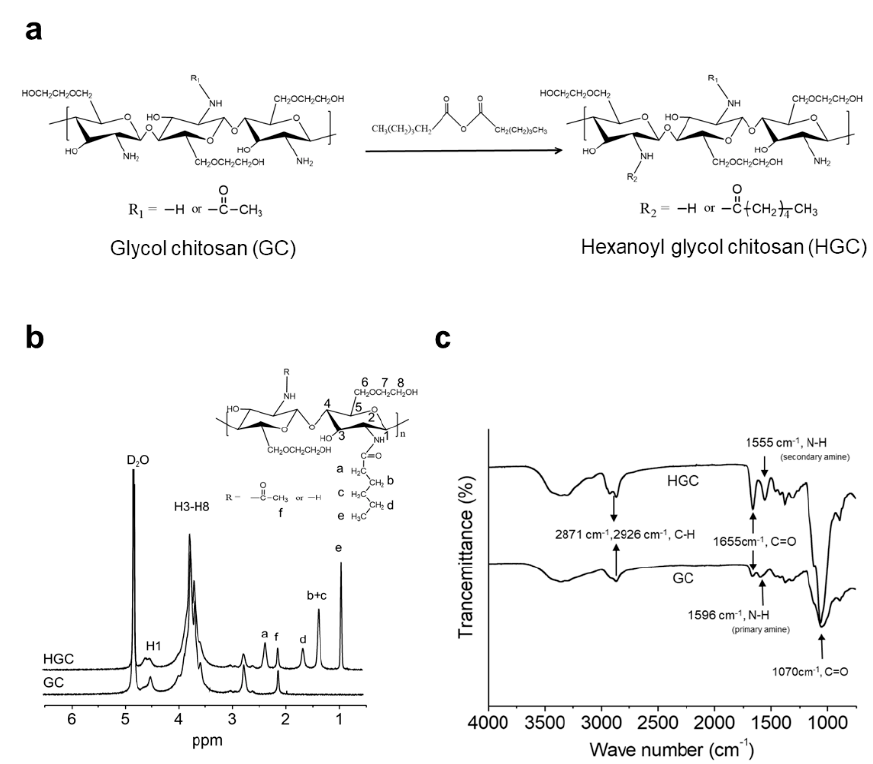
Figure 1. Characterization of hexanoyl glycol chitosan. ( a ) Synthesis procedure of hexanoyl glycol chitosan (HGC)36.9; ( b ) 1 H NMR spectra and ( c ) FT-IR spectra of HGC36.9 and glycol chitosan (GC).